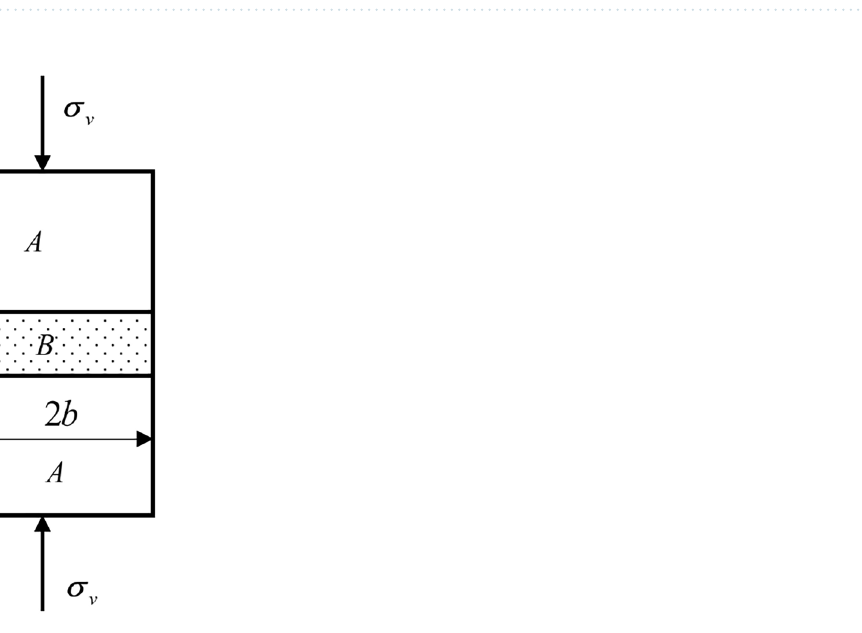
Figure 3. TAW-200 electronic multi-function material mechanics testing machine.